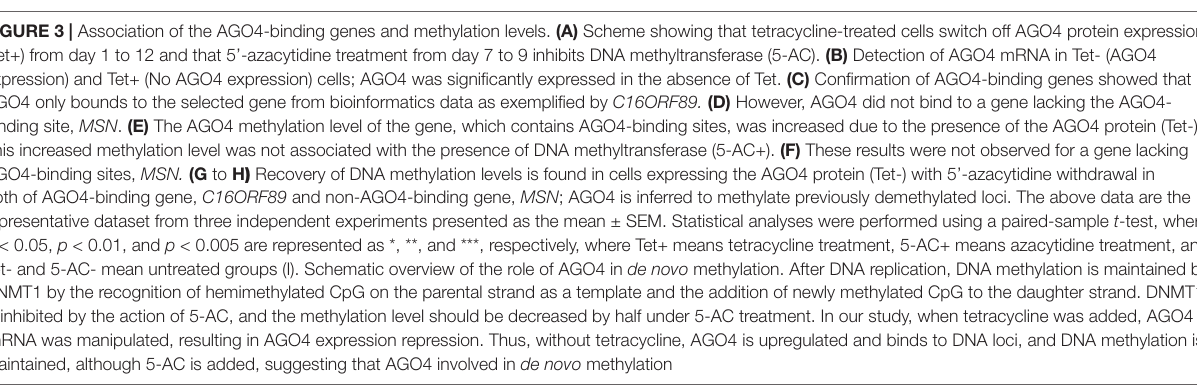
FIGURE 3 | Association of the AGO4-binding genes and methylation levels. (A) Scheme showing that tetracycline-treated cells switch off AGO4 protein expression (Tet+) from day 1 to 12 and that 5’-azacytidine treatment from day 7 to 9 inhibits DNA methyltransferase (5-AC). (B) Detection of AGO4 mRNA in Tet- (AGO4 expression) and Tet+ (No AGO4 expression) cells; AGO4 was significantly expressed in the absence of Tet. (C) Confirmation of AGO4-binding genes showed that AGO4 only bounds to the selected gene from bioinformatics data as exemplified by C16ORF89. (D) However, AGO4 did not bind to a gene lacking the AGO4- binding site, MSN . (E) The AGO4 methylation level of the gene, which contains AGO4-binding sites, was increased due to the presence of the AGO4 protein (Tet-). This increased methylation level was not associated with the presence of DNA methyltransferase (5-AC+). (F) These results were not observed for a gene lacking AGO4-binding sites, MSN. (G to H ) Recovery of DNA methylation levels is found in cells expressing the AGO4 protein (Tet-) with 5’-azacytidine withdrawal in both of AGO4-binding gene, C16ORF89 and non-AGO4-binding gene, MSN ; AGO4 is inferred to methylate previously demethylated loci. The above data are the representative dataset from three independent experiments presented as the mean ± SEM. Statistical analyses were performed using a paired-sample t -test, where p < 0.05, p < 0.01, and p < 0.005 are represented as *, **, and ***, respectively, where Tet+ means tetracycline treatment, 5-AC+ means azacytidine treatment, and Tet- and 5-AC- mean untreated groups (I). Schematic overview of the role of AGO4 in de novo methylation. After DNA replication, DNA methylation is maintained by DNMT1 by the recognition of hemimethylated CpG on the parental strand as a template and the addition of newly methylated CpG to the daughter strand. DNMT1 is inhibited by the action of 5-AC, and the methylation level should be decreased by half under 5-AC treatment. In our study, when tetracycline was added, AGO4 shRNA was manipulated, resulting in AGO4 expression repression. Thus, without tetracycline, AGO4 is upregulated and binds to DNA loci, and DNA methylation is maintained, although 5-AC is added, suggesting that AGO4 involved in de novo